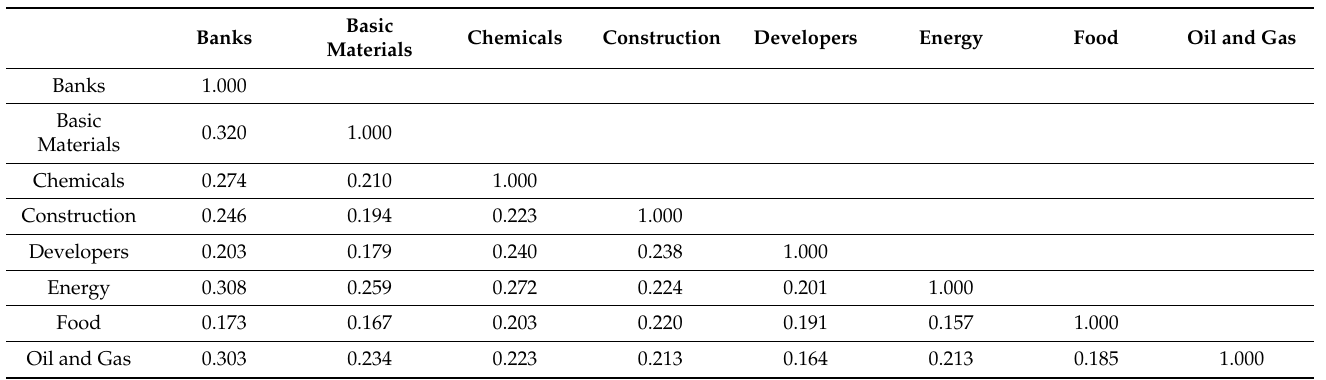
Table 3. Estimation of the Spearman correlation coefficient between the volatilities of stock market